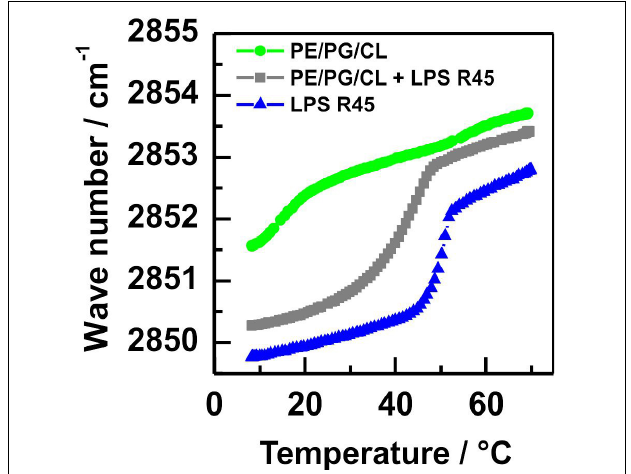
FIGURE 1 | The equimolar mixture of LPS R45 and PL has a phase transition between those of LPS and PL alone. Phase transitions of membranes reconstituted from pure phospholipids ( • ), pure LPS R45 ( (cid:78) ), and an equimolar mixture of both ( (cid:4) ) were recorded in FTIR measurements by measuring the symmetric CH 2 -stretching vibrations within a temperature window from 10 ◦ C to 70 ◦ C. The lipid mixture PE/PG/CL (81:17:2 w/w/w) shows a broad phase transition around 17 ◦ C, whereas for the pure LPS R45 a well-defined phase transition at 50 ◦ C is detected. The equimolar mixture of both, phospholipids and LPS exhibits a shifted phase transition to lower temperatures (T m = 42 ◦ C) with a slightly less sharp characteristic. All experiments were performed with LPS and lipid concentration of 20 mM in 100 mM KCl, 5 mM MgCl 2 , 5 mM HEPES at pH